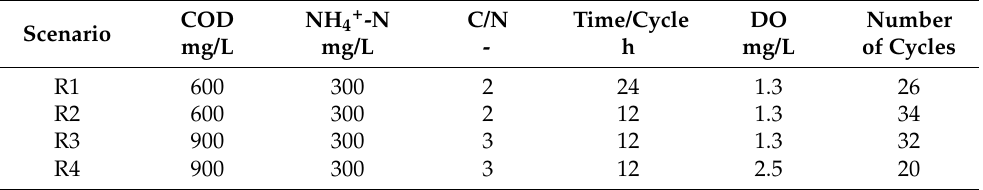
Table 2. Operational conditions of the SBPBBR under four